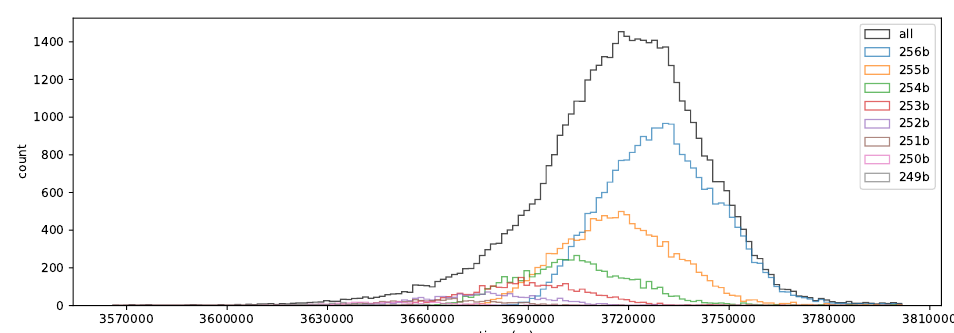
Figure 14: Histogram of signing duration for different number of leading zeros of the random nonces on the secp256r1 curve using the libgcrypt library.